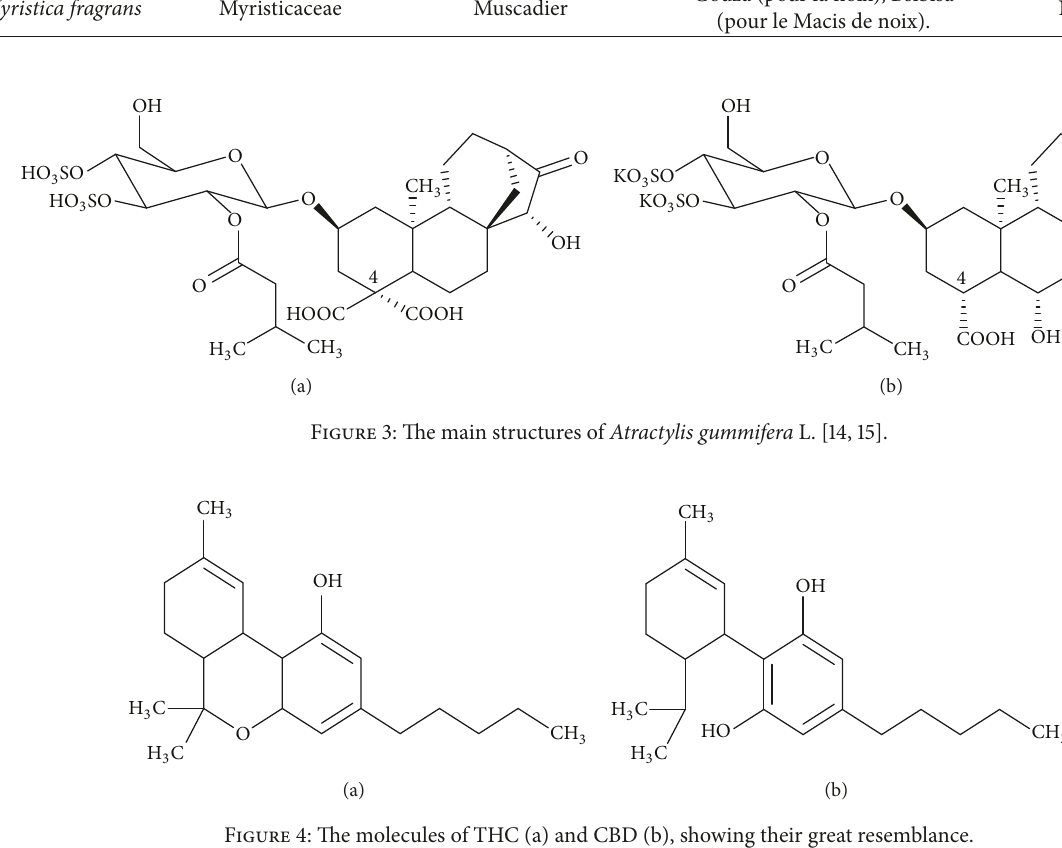
Figure 4: The molecules of THC (a) and CBD (b), showing their great